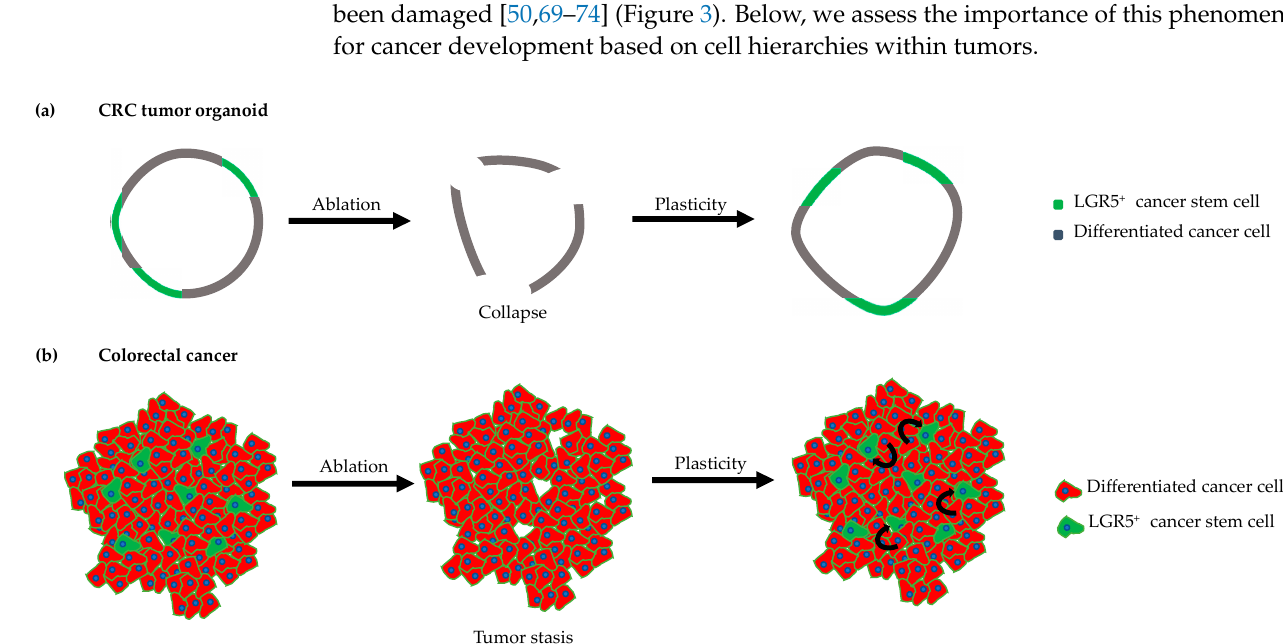
Figure 3. Cancer stem cells (CSCs) are a minority of the tumor mass. ( a ) The ablation of CSCs ex vivo results in a collapse of the tumor organoid. Plasticity enables differentiated cancer cells to become CSCs. ( b ) In an in vivo setting, the ablation of CSCs led to tumor stasis and the reoccurrence of CSCs derived from differentiated cancer cells.